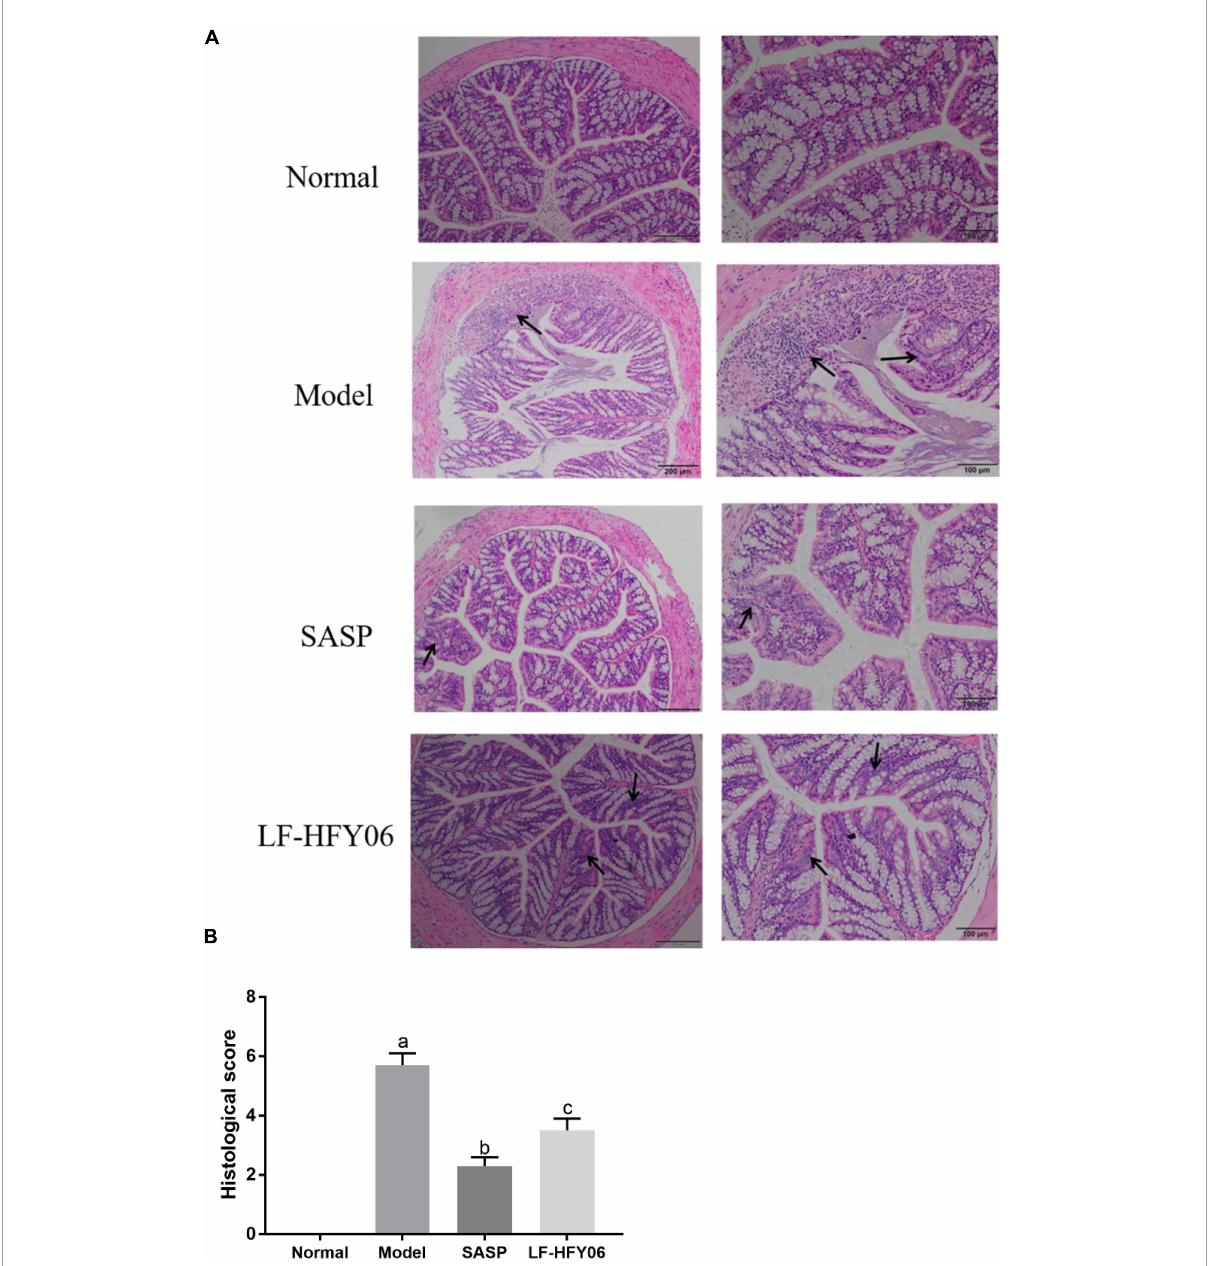
FIGURE3 (A) Histopathological examination of colon tissue sections. (B) Histological disease score of colon tissue sections in mice of the different groups.